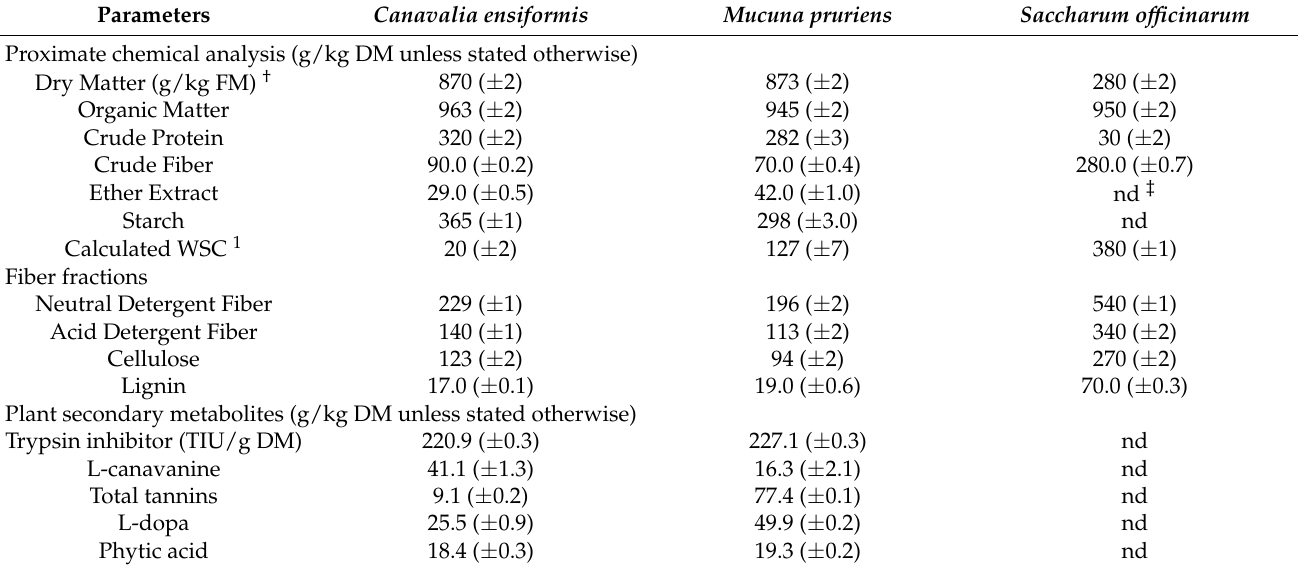
Table 1. Mean ( ± standard deviation) of chemical composition and some plant secondary metabolites of bean and forage meals of two tropical legumes and sugarcane stalks, respectively ( n =